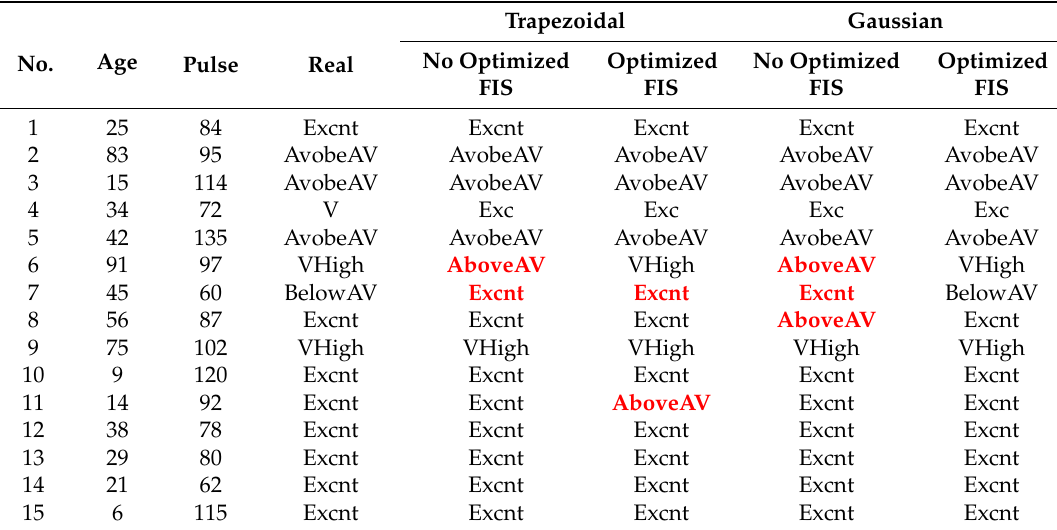
Table 14. Test with random patients using the IT2FS.